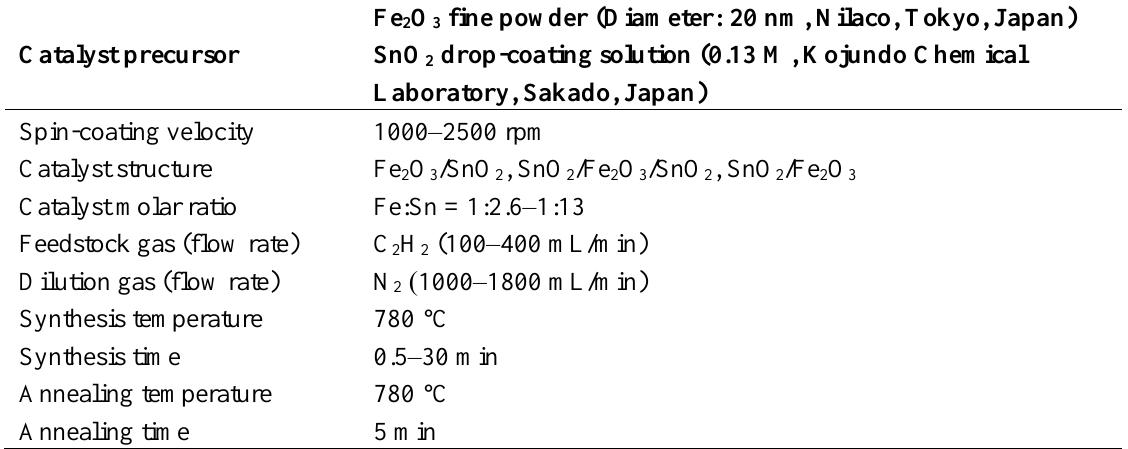
Table 2. Catalytic vapor deposition (CCVD) conditions.